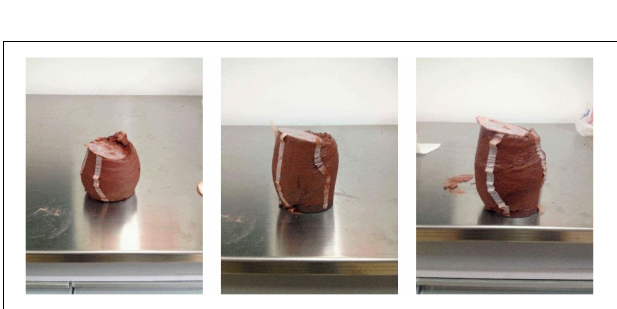
FIGURE 11 | Failure patterns after creep